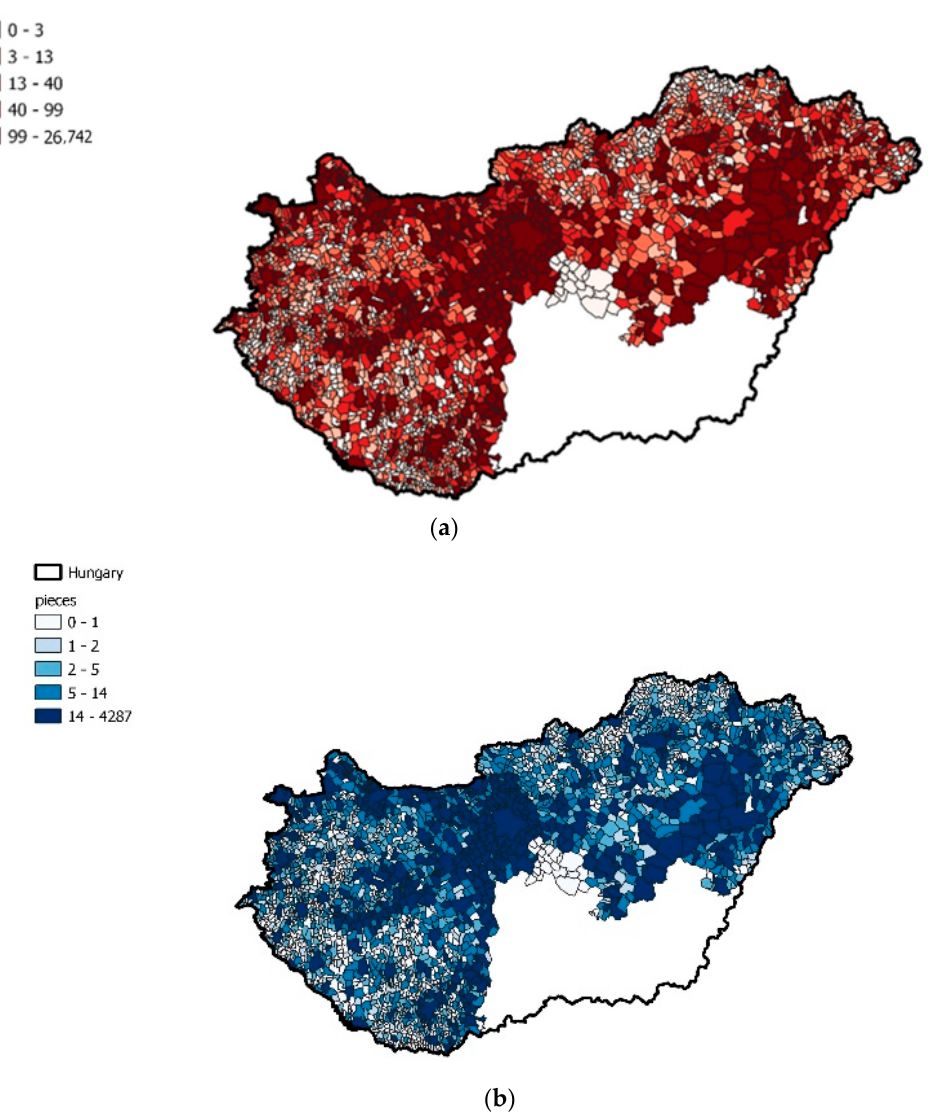
Figure 9. The total power ( a ) and number ( b ) of HMKEs (grid-connected household-size small PV power plants) in the settlements of Hungary on 31 December 2019 [70].